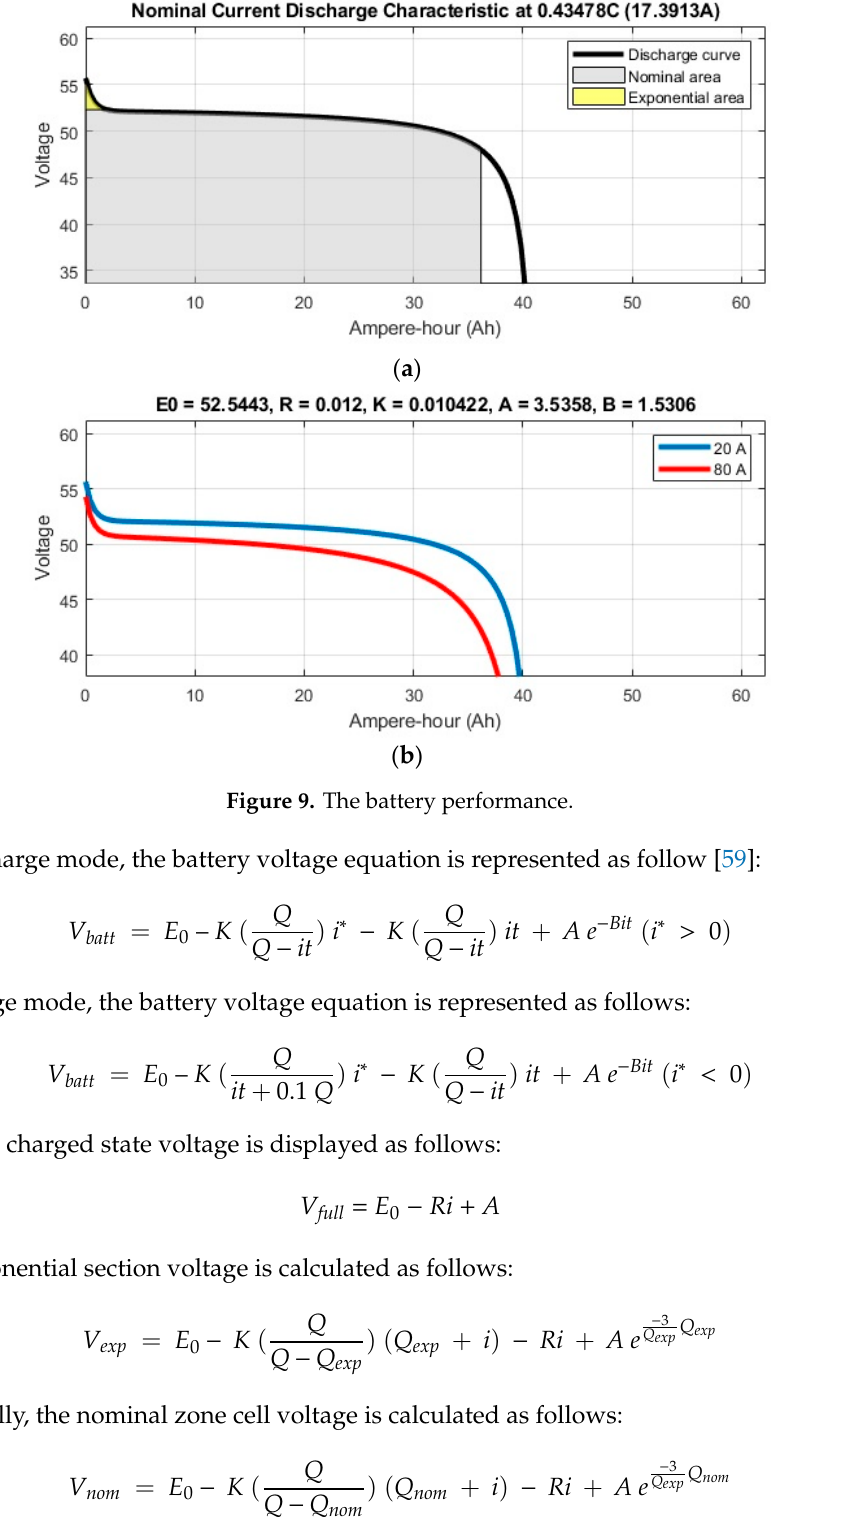
Table 6. Supercapacitor (SC) self-discharge parameters.